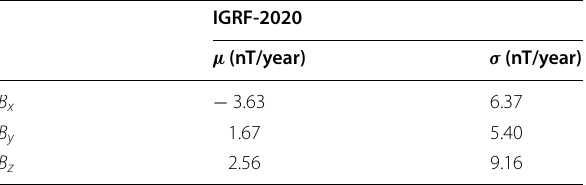
Table 2 Statistics of our IGRF-13 candidate SV model with respect to observatory measurements. Columns show residual mean ( µ ) and standard deviation ( σ ) for the model minus observatory spline fits for epoch 2020.0. The residuals are computed from observatory data within ± 55 ◦ geomagnetic dipole